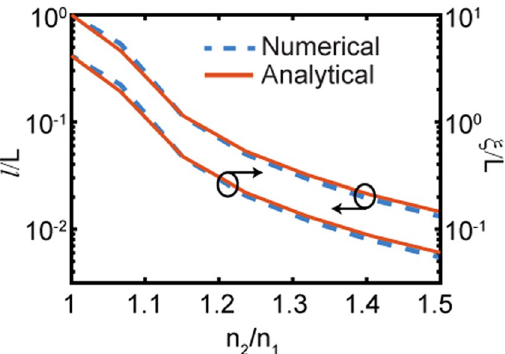
Figure 9. Localization length and scattering mean free path of the RS sample as a function of refractive index contrast. Dashed lines represent localization length normalized to the sample length. Solid lines represent the same calculated using the analytical formula derived for random systems 53